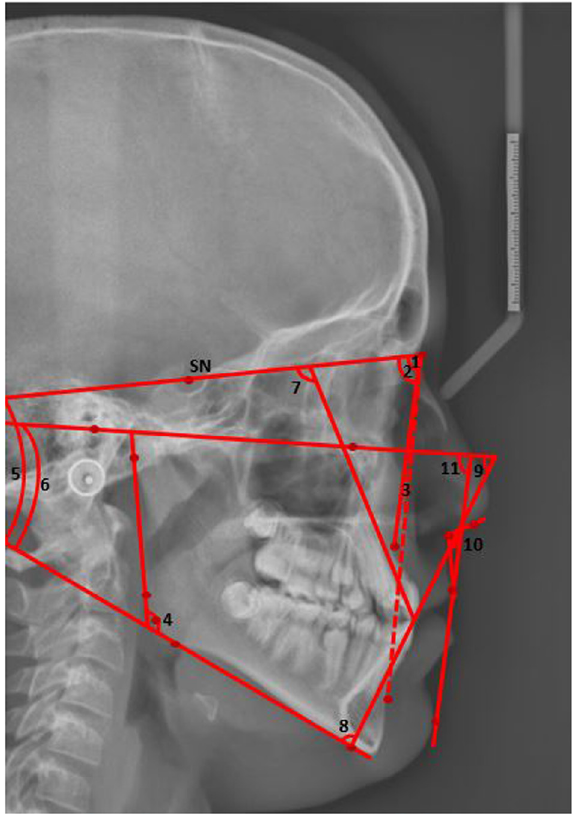
Figure 2. (1) SNA, (2) SNB, (3) ANB, (4) gonial angle, (5) SN/GoMe, (6) FMA, (7) FMIA, (8) IMPA, (9) U1/SN, (10) nasolabial angle, (11) Z angle.